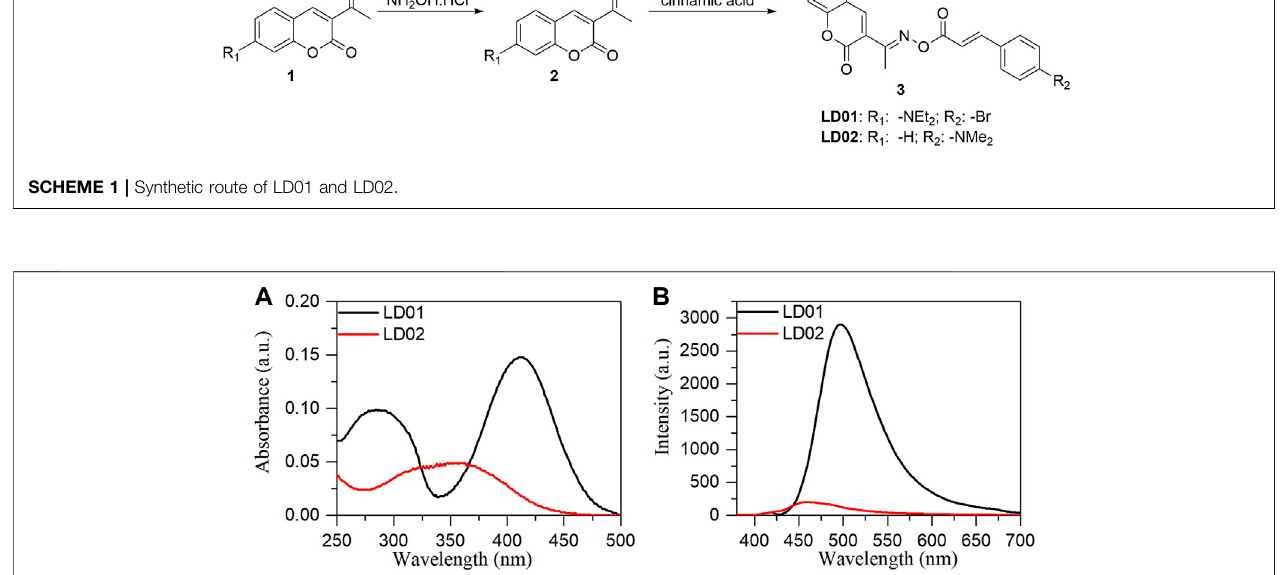
Frontiers in Chemistry |